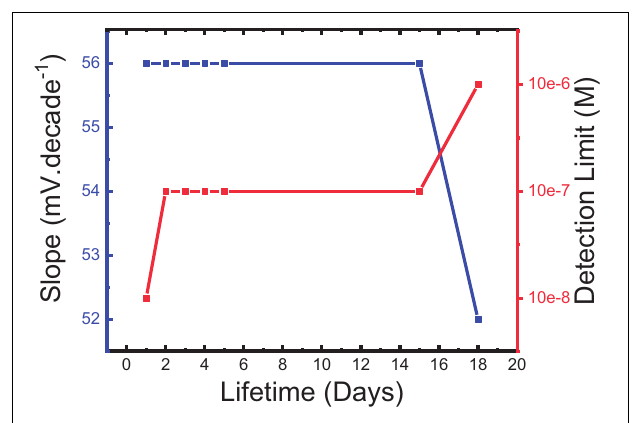
FIGURE 12 | Slope of sensor 5 and its corresponding detection limit for IVR drug at the different lifetimes.